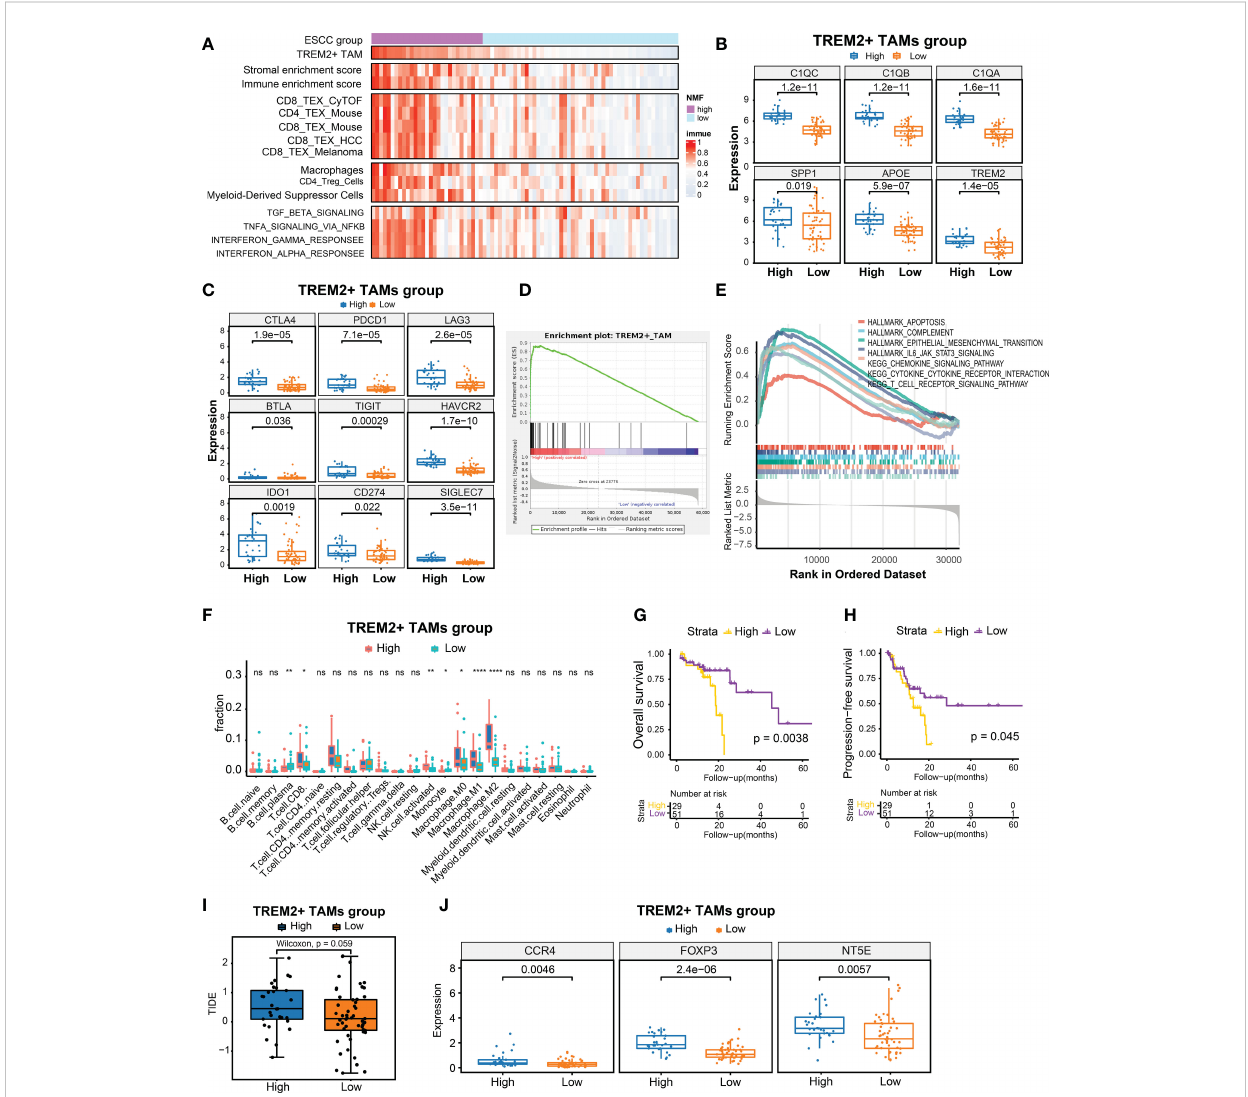
FIGURE 5 Identi fi cation of high TREM2+ TAMs-enriched group in 80 ESCC from TCGA. (A) Heatmap of 80 ESCC ordered by enrichment score of TREM2+ TAM gene signature, showing enrichment scores of immune, stromal, T cell exhaustion signatures, immunosuppressive cells, and T cell exhaustion related pathways. (B) Boxplot showing differential expression level of TREM2+ TAM signature genes between High and Low group. (C) Boxplot showing differential expression level of 9 immune checkpoint genes between two groups. (D, E) Gene set enrichment analysis for TREM2+ TAM gene signature (D) and hallmark gene sets and KEGG pathways between two groups. (F) Comparison of cell fraction inferred by CIBERSORT between two groups. (G, H) Kaphan-Meier estimates of overall survival and progression-free survival according to high TREM2+ TAMs-enriched group. (I) Boxplot showed prediction scores generated by TIDE between two groups. One-side Wilcoxon. (J) Expression analysis of genes related to immunotherapy resistance between high TREM2+ TAMs-enriched and low groups. All statistical signi fi cances of two classes were computed